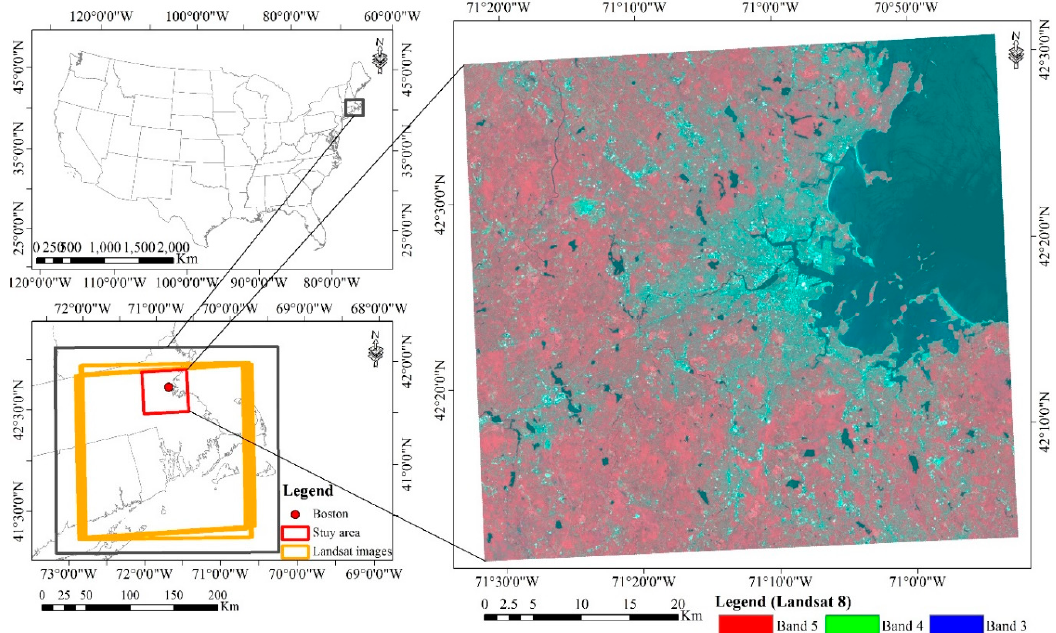
Figure 1. Study area and an example Landsat 8 OLI image acquired on 13 July 2016.